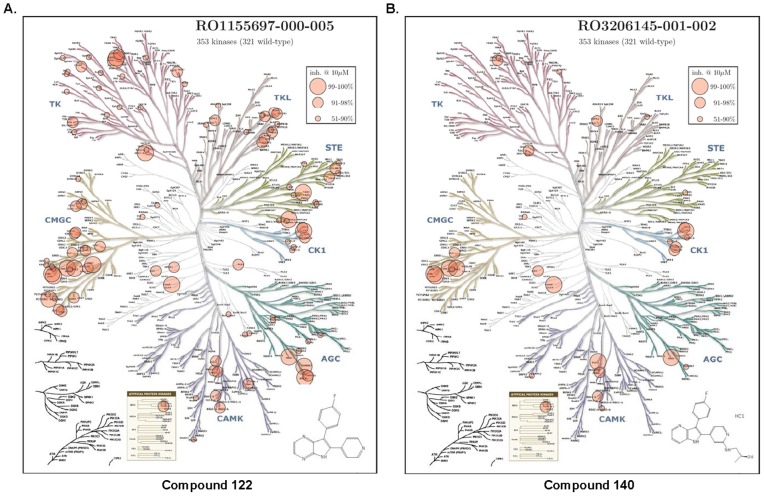
The selectivity of compounds 122 and 140 presented on a dendrogram of the human kinome.
A. Compound 122 at 10 µM. B. Compound 140 at 10 µM. Pink circle represents inhibitory activity: big circle, 99–100% inhibition; intermediate circle, 91–98% inhibition; small circle, 51–90% inhibition.